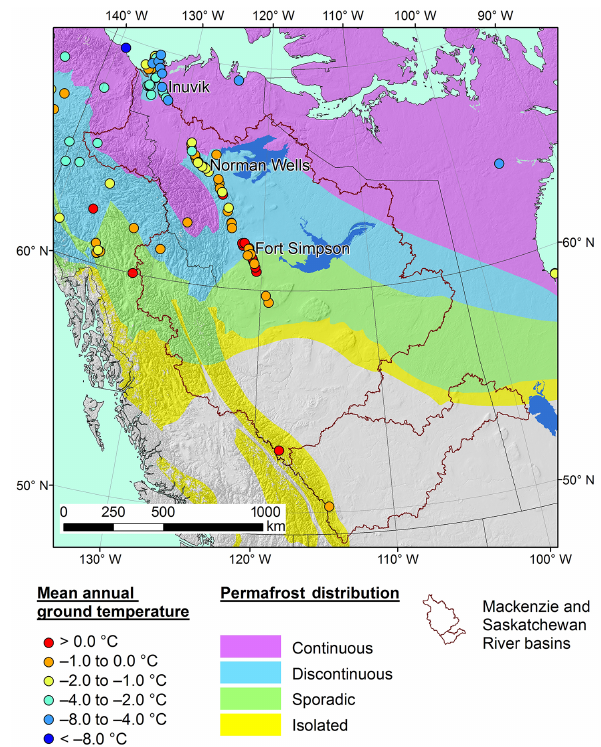
Figure 9. Distribution of permafrost over western Canada (from Brown et al., 2001) and mean annual ground temperature (MAGT) recorded during the IPY (2007–2009) (from IPA,